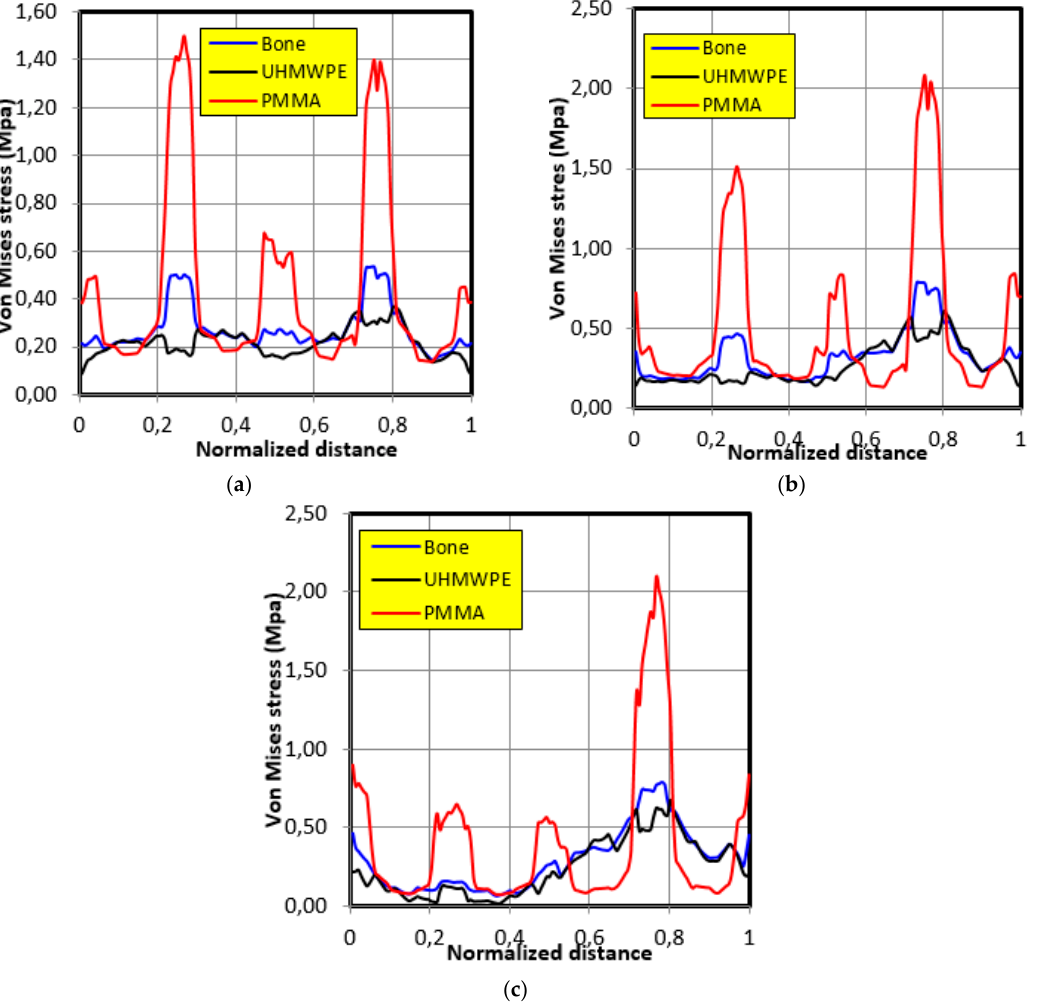
Figure 12. The Von Mises stresses distribution along the graft contour in the case of movement of individual 3. ( a ) 30° position; ( b ) 60° position; ( c ) 90° position.